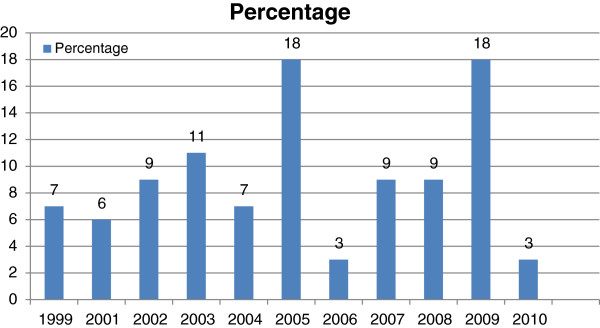
Year of training.